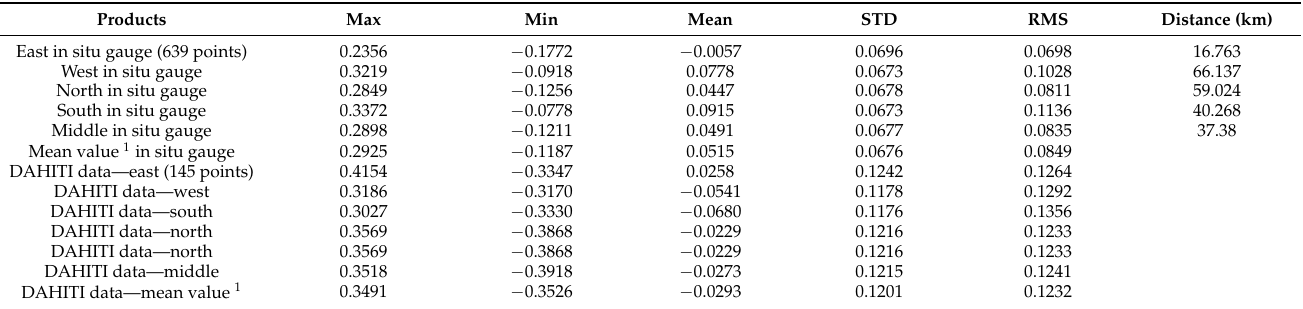
Table 3. Comparison of water level products (m).